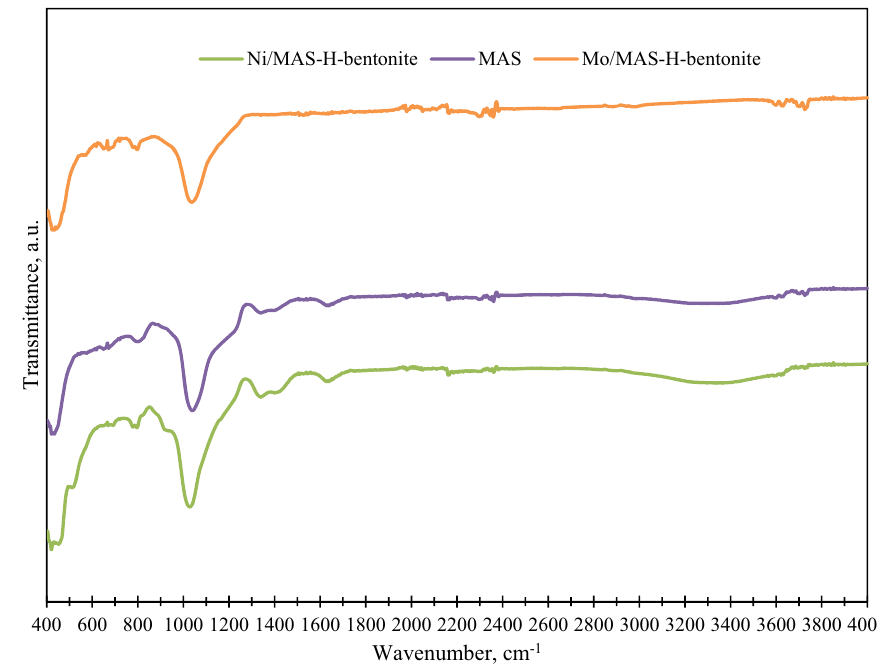
Figure 7: FTIR spectra of synthesized samples: MAS, Ni/MAS - bentonite, and Mo/MAS - bentonite bifunctional catalysts.